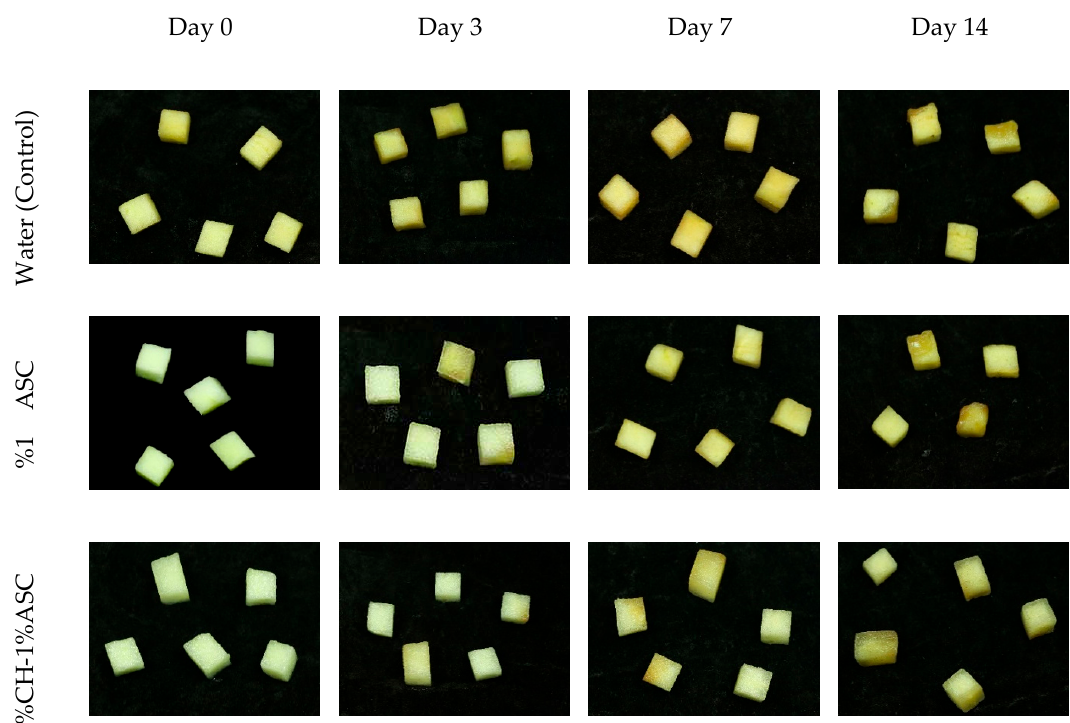
Figure 1. Changes in the browning index (%) values of fresh cut apple samples during storage at 5 ° C. Values are means of two replications. Vertical bars represent standard deviation. Data in the same day with each treatment having different superscript lowercase letters are significantly different ( p < 0.05). Data on each day of storage in the same treatment having different superscript uppercase letters are significantly different ( p < 0.05).